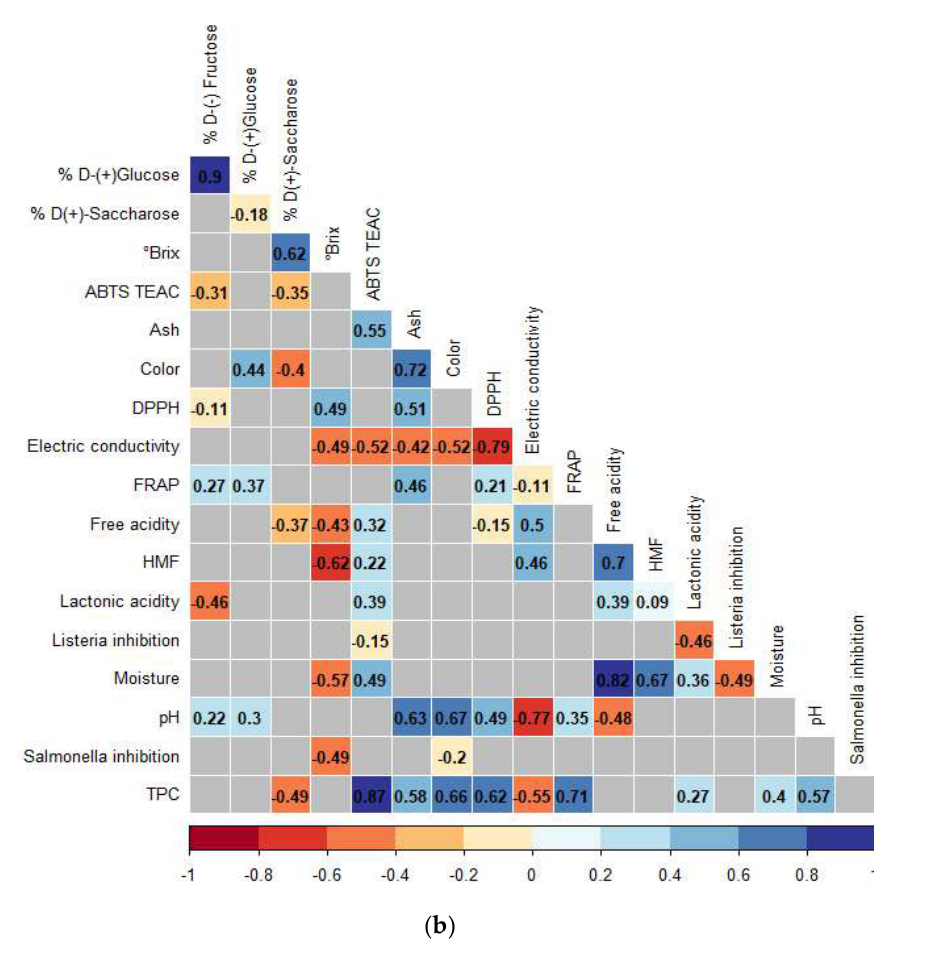
Figure 4. Spearman’s correlation analysis between the variables associated with the quality of honey produced by ( a ) Apis mellifera and ( b ) Melipona eburnea in tropical Colombian forest. he presence of color indicates statistically significant relationships ( p < 0.05), and the intensity of red or blue color indicates the magnitude of the correlation coefficient, whether it is an inversely proportional or directly proportional relationship, respectively.